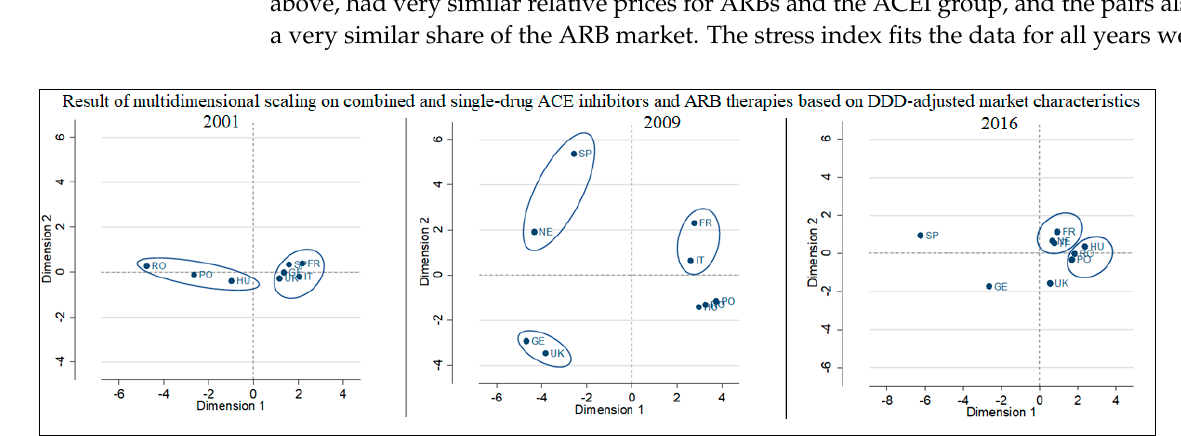
Figure 2. ARB preference index and average ARB and ACEI prices.